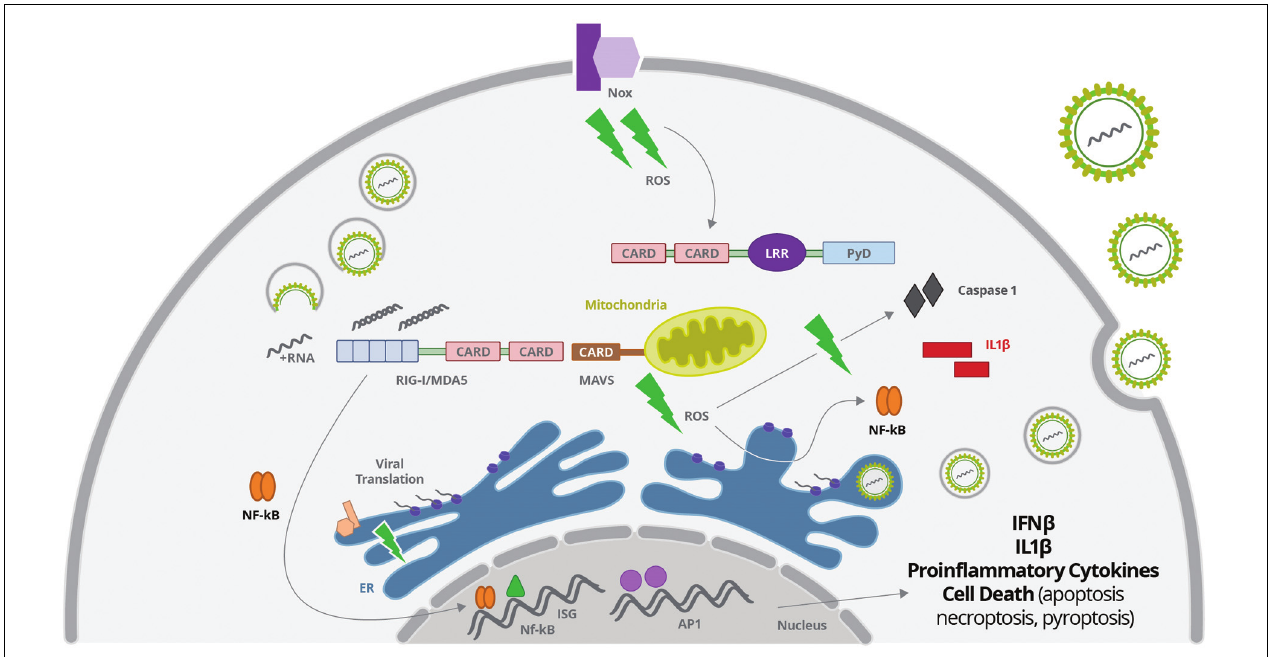
FIGURE 3 | Virus-derived dsRNA is sensed by cytoplasmic RIG-I, leading to activation of IRFs, NF- κ B and AP1 transcription factors, which will promote the secretion of IFN β and proinflammatory cytokines. Virus sensing and replication affect mitochondria function leading to reactive oxygen species (ROS) production, what may activated the inflammasome complex, induce oxidative stress with protein oxidation in the ER, and activate NF- κ B. ROS may be generated from mitochondrial oxidative phosphorylation, or from activation of membrane NADPH oxidase (Nox), among others not represented